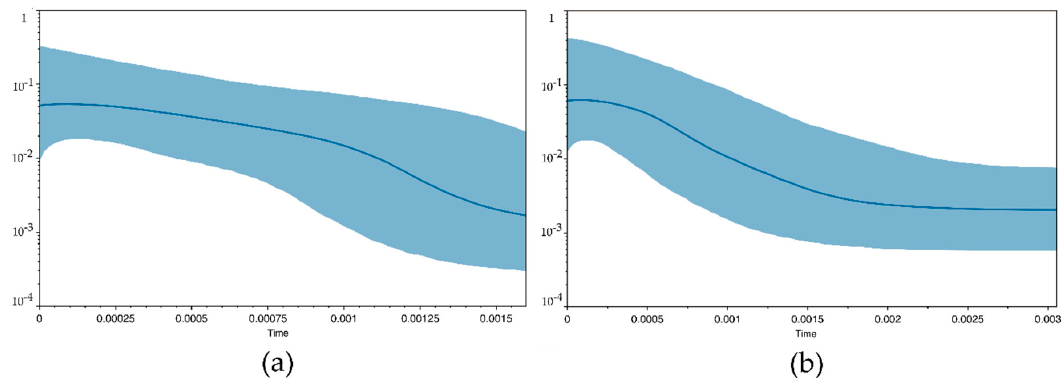
Figure 2. Bayesian skyline plot for Gobius geniporus ( a ) and G. cruentatus ( b ) based on cytochrome b sequence data. The graph illustrates fluctuation of the population size from recent to the coalescence (from left to right). Y-axis stands for scaled effective population size and x-axis for time scale in units of mutation per nucleotide position. Blue middle line shows the median estimate, 95% confidence interval is indicated in blue.